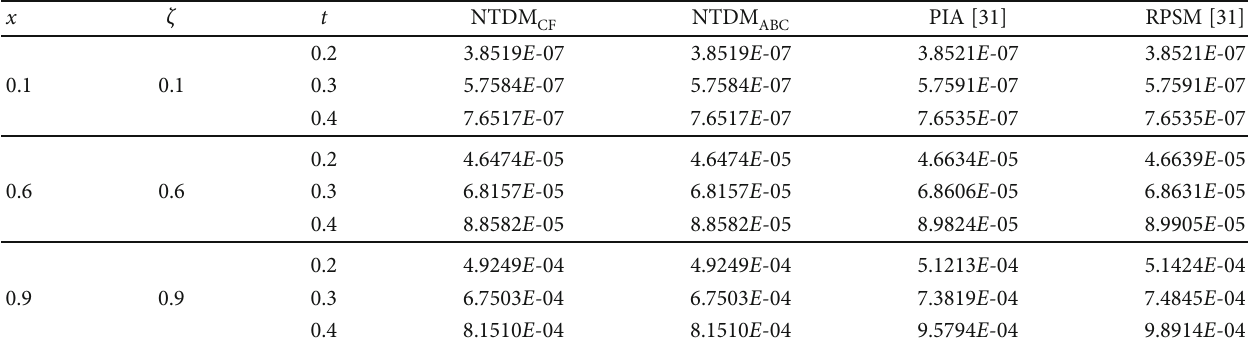
μ = 1 and λ = 0 : 001 .